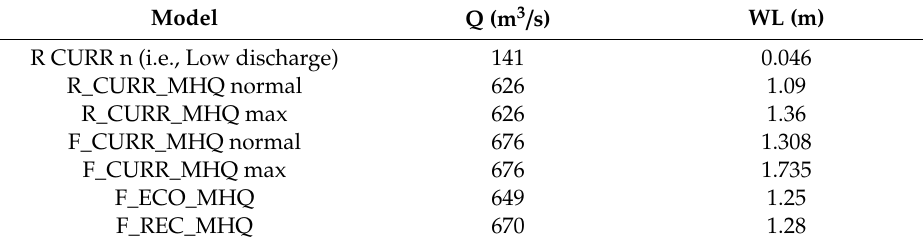
Table 3. The CFD models and their boundary conditions of Part 2 for the reference period (R) and for the future (F). CURR, current regulation rules; ECO, ecologically sustainable regulation rules; REC, regulation rules supporting recreational usage. n refers to normal flow, and MHQ is the mean high discharge with typical water level (normal) and maximum water level (max). Q is the river discharge (m 3 / s) at the upstream boundary, and WL down is the water level in meters at the downstream boundary.